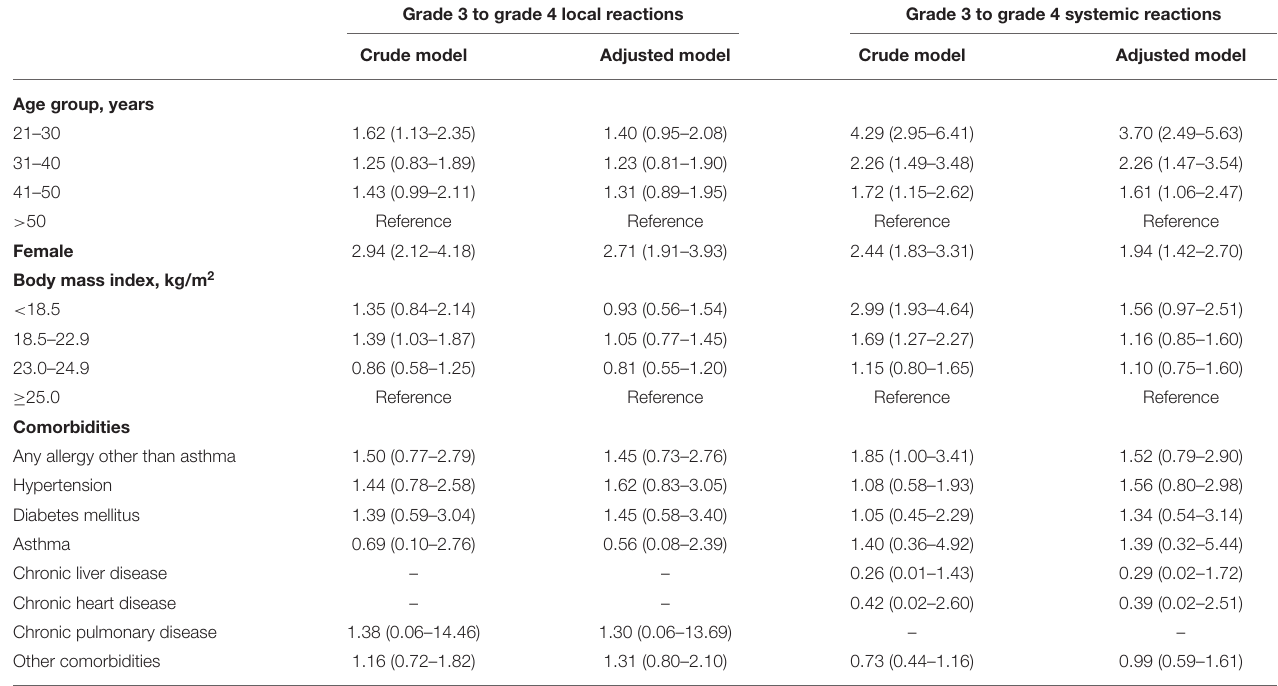
TABLE 3 | Factors associated with grade 3 to grade 4 local and systemic adverse